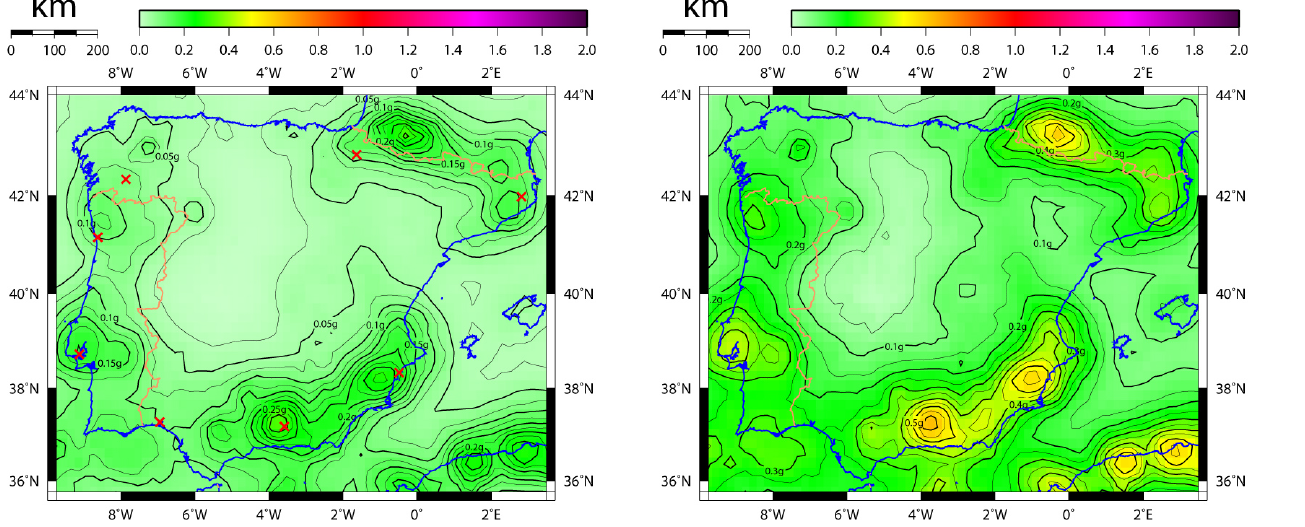
Figure 9. Distribution of the accelerations obtained for T = 0s and 475yr return period.